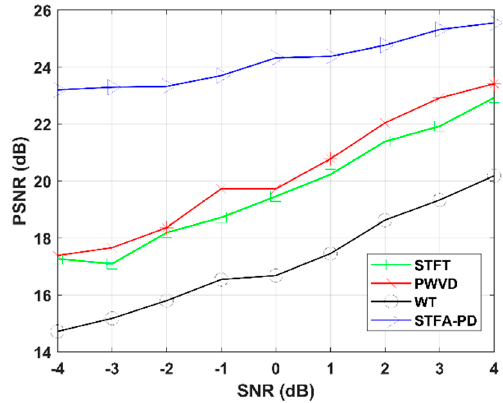
Figure 4. Peak SNR (PSNR) values obtained by different methods (i.e., STFT, PWVD, WT, and the proposed STFA-PD method) at different SNR levels.